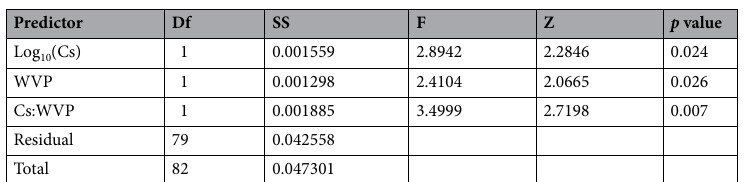
Table 1. Phylogenetic MANCOVA regression for procrustes shape variables. Cs centroid size; WVP water vapour pressure; Df degree of freedom; SS sums-of-square; F Cohen’s F; Z scores (effect-size).